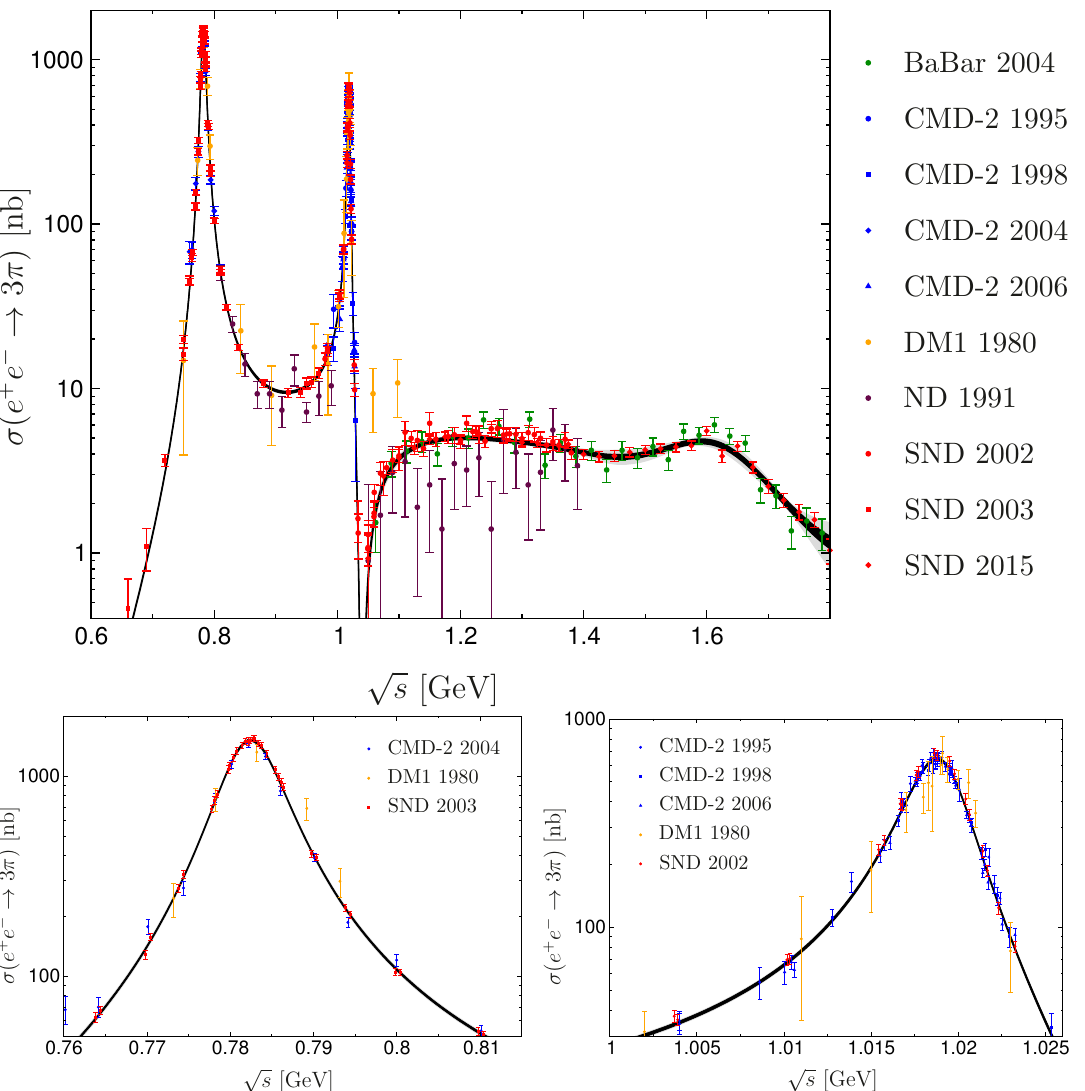
Figure 1 . Fit to the e + e (cid:0) 3 (cid:25) data sets as listed in table 1 (with VP removed everywhere). The ! black band includes the (cid:12)t uncertainties only, while the gray band represents the total uncertainty, including the systematics of the dispersive representation. For most energies the two uncertainties are of similar size, so that the di(cid:11)erence is hardly visible on the logarithmic